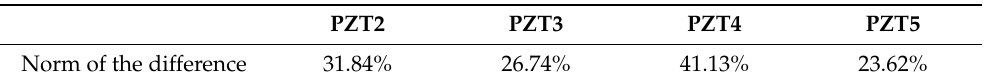
Figure 8. Responses of the PZTs with the plate in rest conditions (blue curves) or cantilever conditions (red curves). Table 1. Norm of the difference between the PZT responses acquired with the plate in rest conditions or cantilever